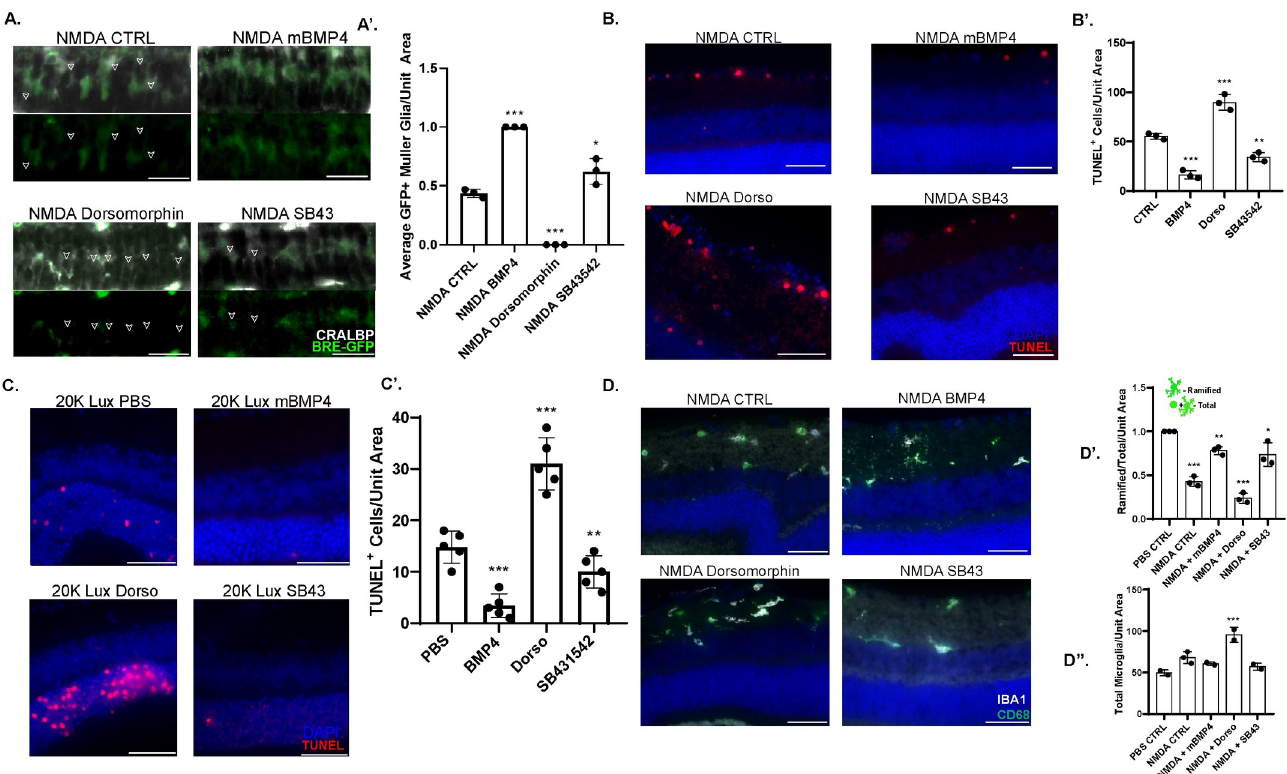
Fig 4. Modulation of the BMP/TGF β signaling pathway affects tissue damage induced retinal apoptosis and immune activation. 3.5 m/o BRE-eGFP reporter mice intravitreally injected with 25mM NMDA were treated with either; PBS control, mBMP4, Dorsomorphin (BMP Inhibitor), or SB431542 (TGF β Inhibitor). At 48 hours, BRE-GFP (green) colocalization assessed and quantified with Muller glial marker, CRALBP (white) and plotted following various treatments in comparison to control NMDA (4A-A’). TUNEL assay (red) was performed under above conditions, with total TUNEL+ cells plotted in comparison to control (4B-B’). Effects of various treatments tested in light damage conditions following 20,000 Lux exposure for 1.5 hours with retina collected 48 hours post exposure. TUNEL assay was then performed and quantified in comparison to control (4C-C’). Retinal tissue analysis for immune markers IBA1 (white) and CD68 (green), with ratio of ramified morphology immune cells over total compared between conditions (4D-D’). Total number of activated CD68+ immune cells was also compared between treatment conditions (4D-D”). Scale Bar: 20 μ m (4-A). 30 μ m (4B-D). Experiments were conducted with n = 2 replicates and n = 3–5 mice/ condition. Error bars indicate s.e.m.; P-values from Student’s t-test. � p < 0.05, �� p < 0.01, �� p < 0.001. DAPI (blue) marks nuclei in all